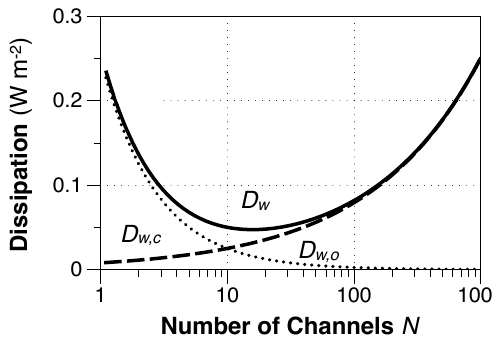
Fig. 5. Demonstration of a state of minimum dissipation of kinetic energy of water flow due to the presence of channels. The graph shows the sensitivity of total dissipation, D w , as well as the two components (dissipation by overland and channel flow, D w,o and D w,c , respectively) to the density of channels, N